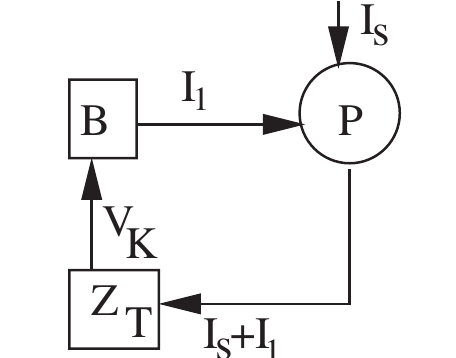
FIG. 2. Circuit schematic of the cooling feedback